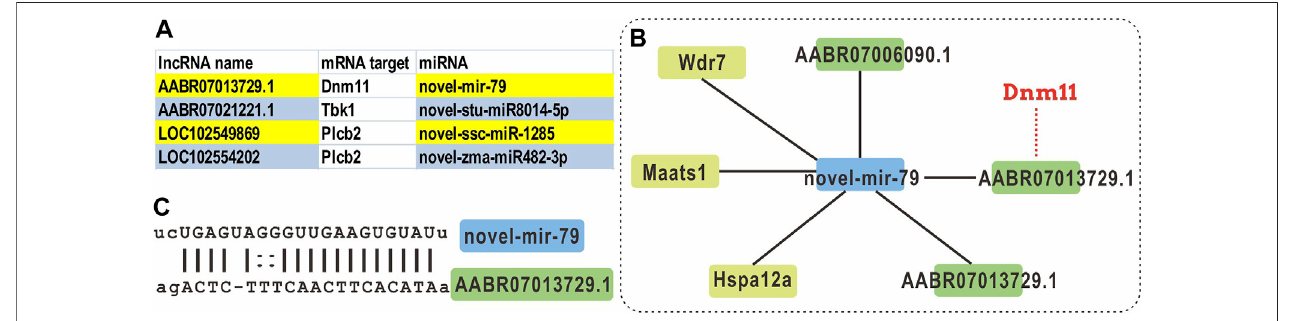
FIGURE 6 | ceRNA analysis of the DElncRNAs with NLR signaling pathway gene targets. (A) The lncRNAs with an mRNA target that is categorized as a NRL signaling pathway gene, and its miRNA target. (B) The ceRNA network of novel-mir-79. (C) The alignment of novel-mir-79 and lncRNA AABR07013739.1.